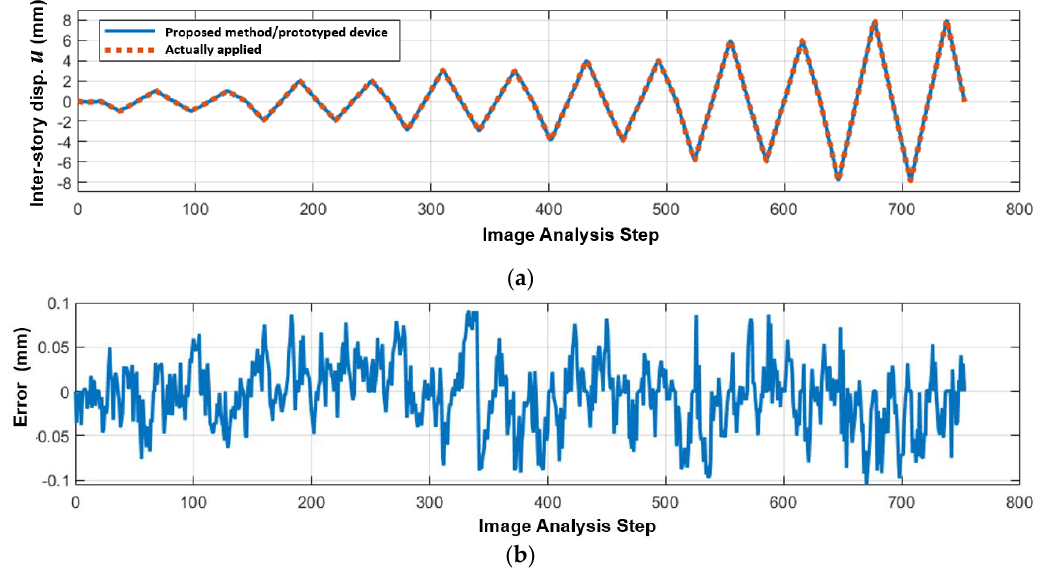
Figure 6. Comparison of the actual applied and measured inter-story displacements and the errors. ( a ) Measured and actually applied (controlled) inter-story displacement u . ( b ) Error of measured inter-story displacement u (image measured).